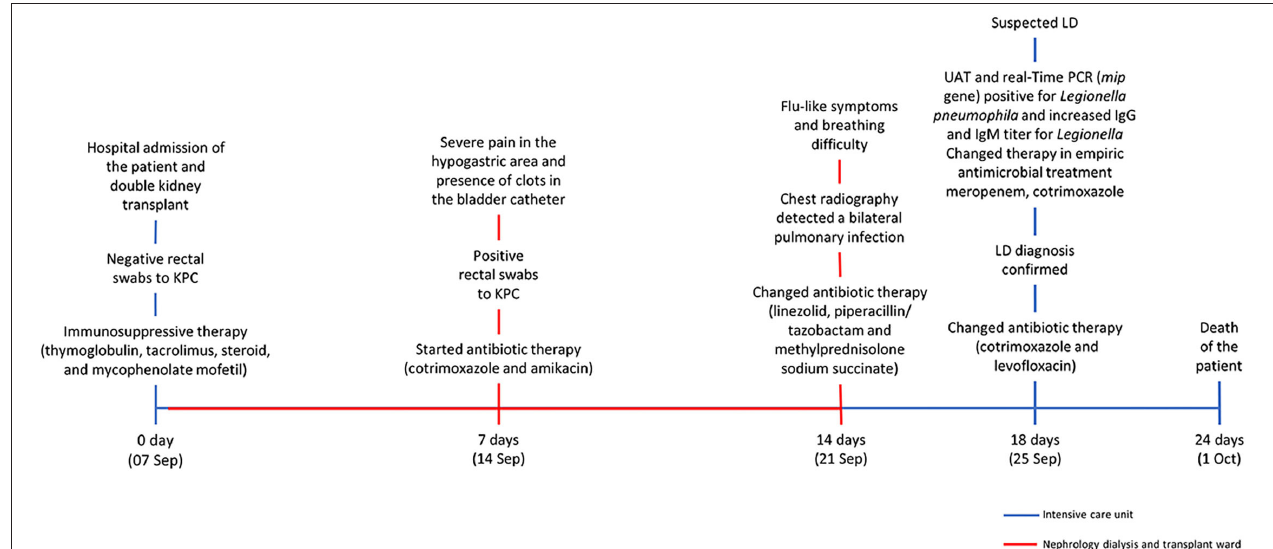
FIGURE 1 | The hospitalization timeline and the clinical